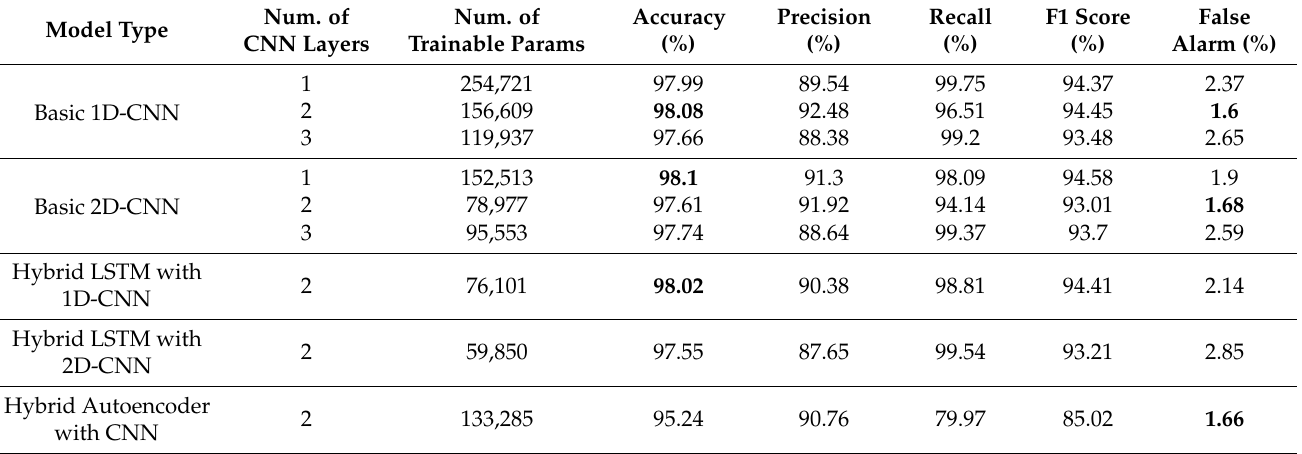
Table 14. The experimental results on the NSL-KDD dataset. Model